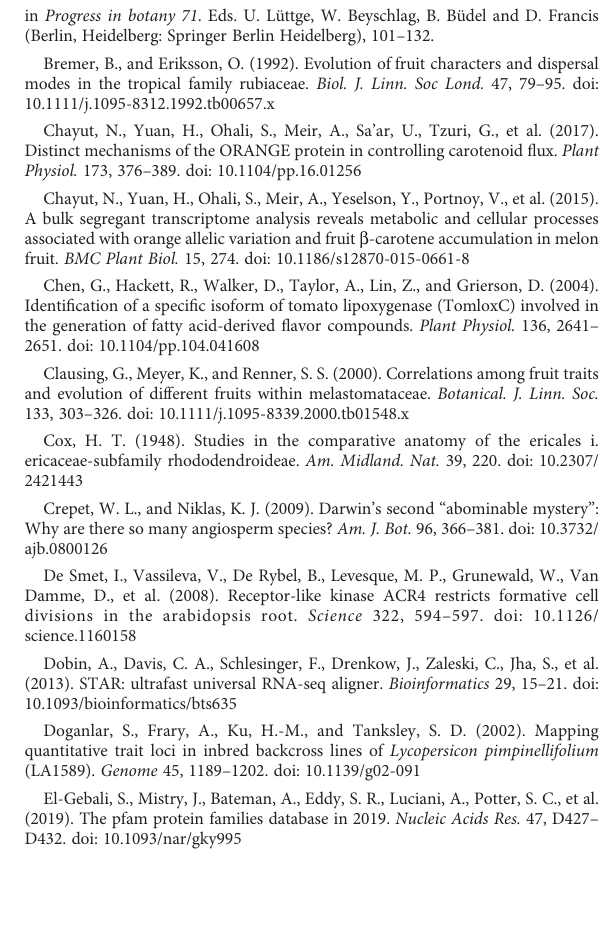
SUPPLEMENTARY FILE 1 List of gene names for conserved orthologous genes.